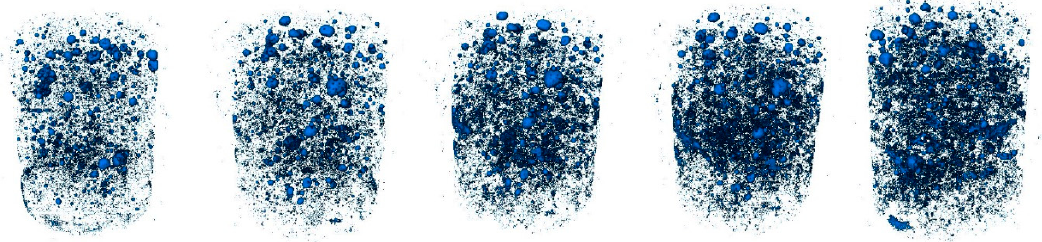
Figure 5. Three-dimensional (3D) views of the voids belonging to plain concrete at different ages. Age increases from left to right . Figure 6. 3D views of the voids belonging to steel fiber-reinforced concrete at different ages. Age increases from left to right .